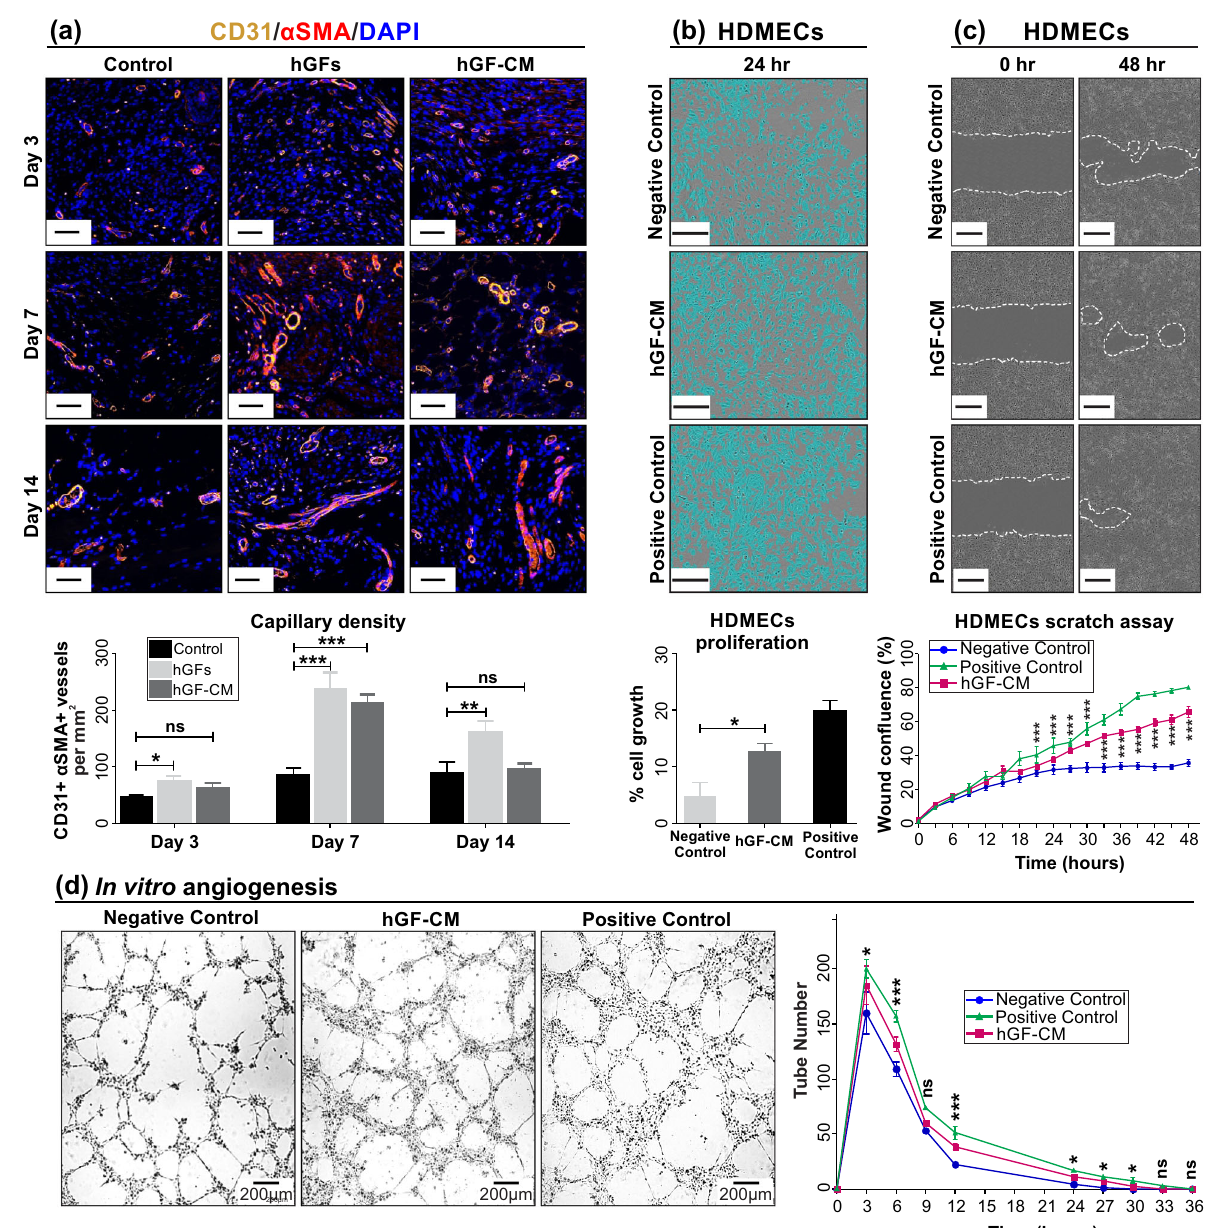
Fig. 4 The effect of hGFs and hGF-CM on angiogenesis. a Immuno fl uorescent detection and quanti fi cation of CD31 + and α SMA + mature blood vessels (structures) in hGFs and hGF-CM treated and control wounds. Images captured at ×20 objective. Scale bars represent 0.2 mm. n = 8. b – d The effect of hGF-CM treatment on HDMECs ( b ) proliferation, ( c ) migration and ( d ) angiogenic potency in vitro. Scale bars represent 0.3 mm. n = 6. All data are represented as mean ± SEM. * p < 0.05, ** p < 0.01, *** p < 0.001, ns = nonsigni fi